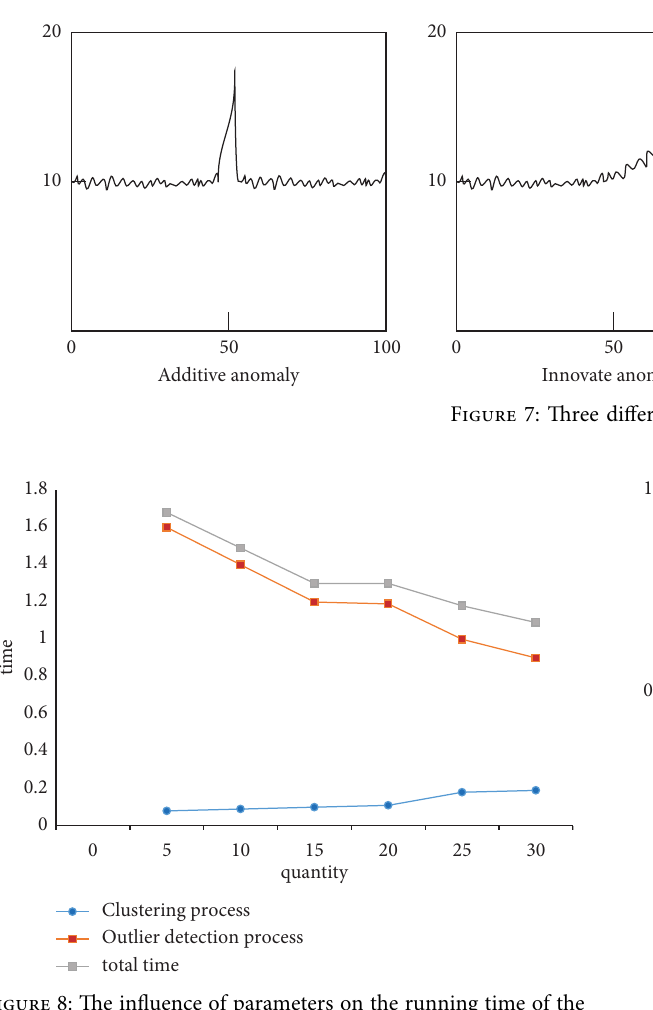
Figure 8: Te infuence of parameters on the running time of the two algorithms.